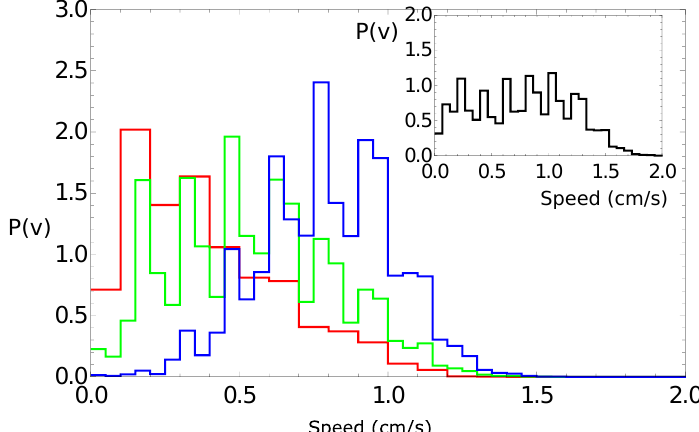
Figure 8. The speed of a pill made of 10% polypropylene and 90% camphene as a function of time, as observed in the three independent experiments.